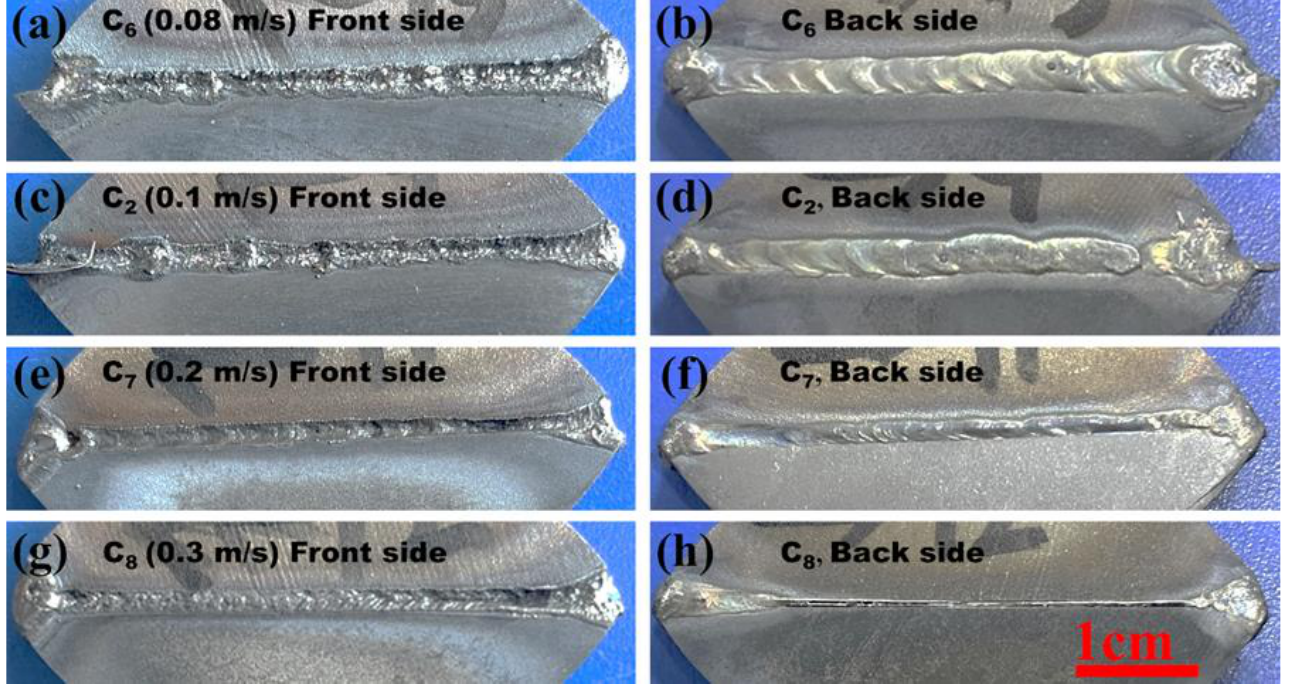
Figure 4. Effect of welding speed on the weld formation using 0.3-mm-thick nickel as brazing filler metal when laser power is 1.2 kW. Front side weld formation. ( a ) Specimen C 6 (0.08 m/s), ( c ) Specimen C 2 (0.1 m/s), ( e ) Specimen C 7 (0.2 m/s), and ( g ) Specimen C 8 (0.3 m/s). Back side weld formation. ( b ) Specimen C 6 , ( d ) Specimen C 2 , ( f ) Specimen C 7 , and ( h ) Specimen C 8